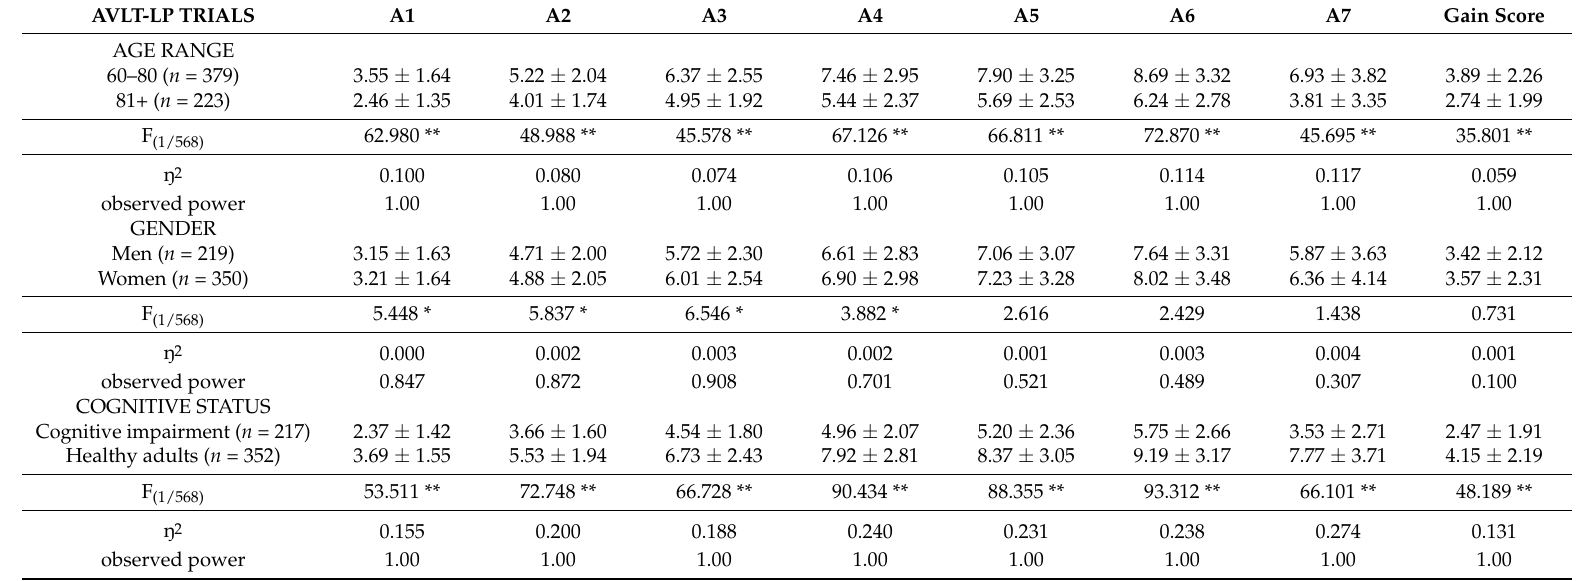
Table 1. Mean scores and differences as a function of the variables analyzed in all Auditory Verbal Learning Test—Learning Potential (AVLT-LP) test trials and in AVLT-LP gain score.